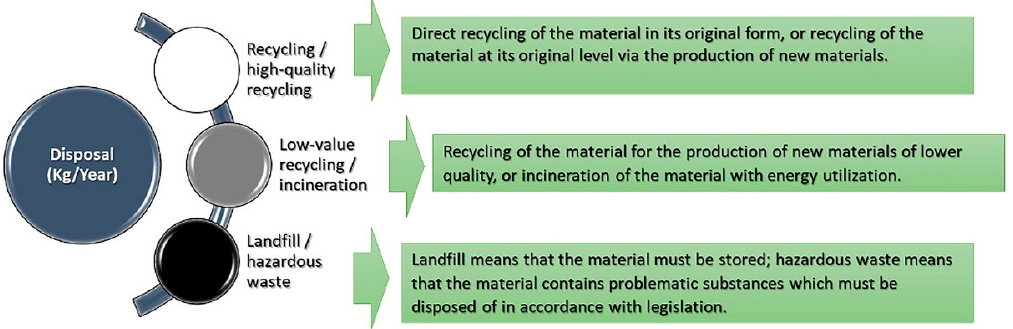
Figure 11. The environmental indicators show the environmental impact of the disposal. Applying this indicator to the selected five wooden façade materials is shown in the below diagram’s results (see Figures 12 and 13).